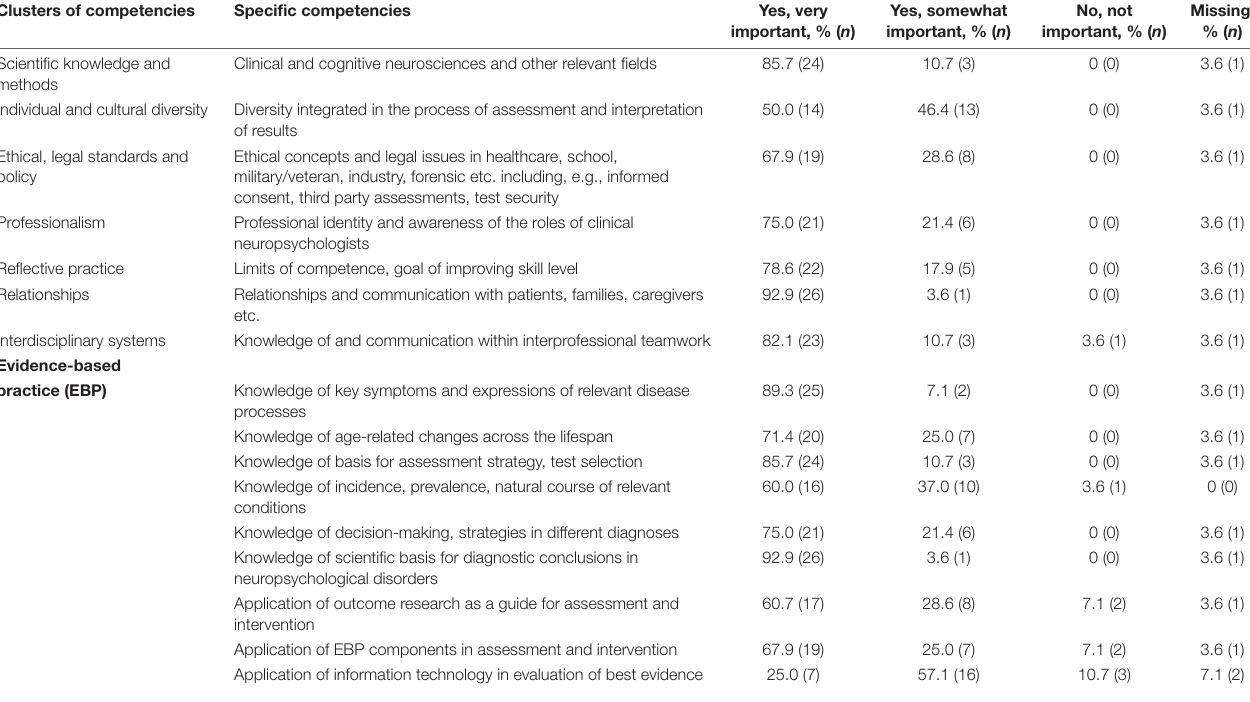
TABLE 1 | Percentage of respondents giving an affirmative or negative response on items pertaining to foundational competencies relevant, but not limited to, clinical neuropsychology: ratings given as yes, very important, yes, somewhat important or no, not important. Clusters of